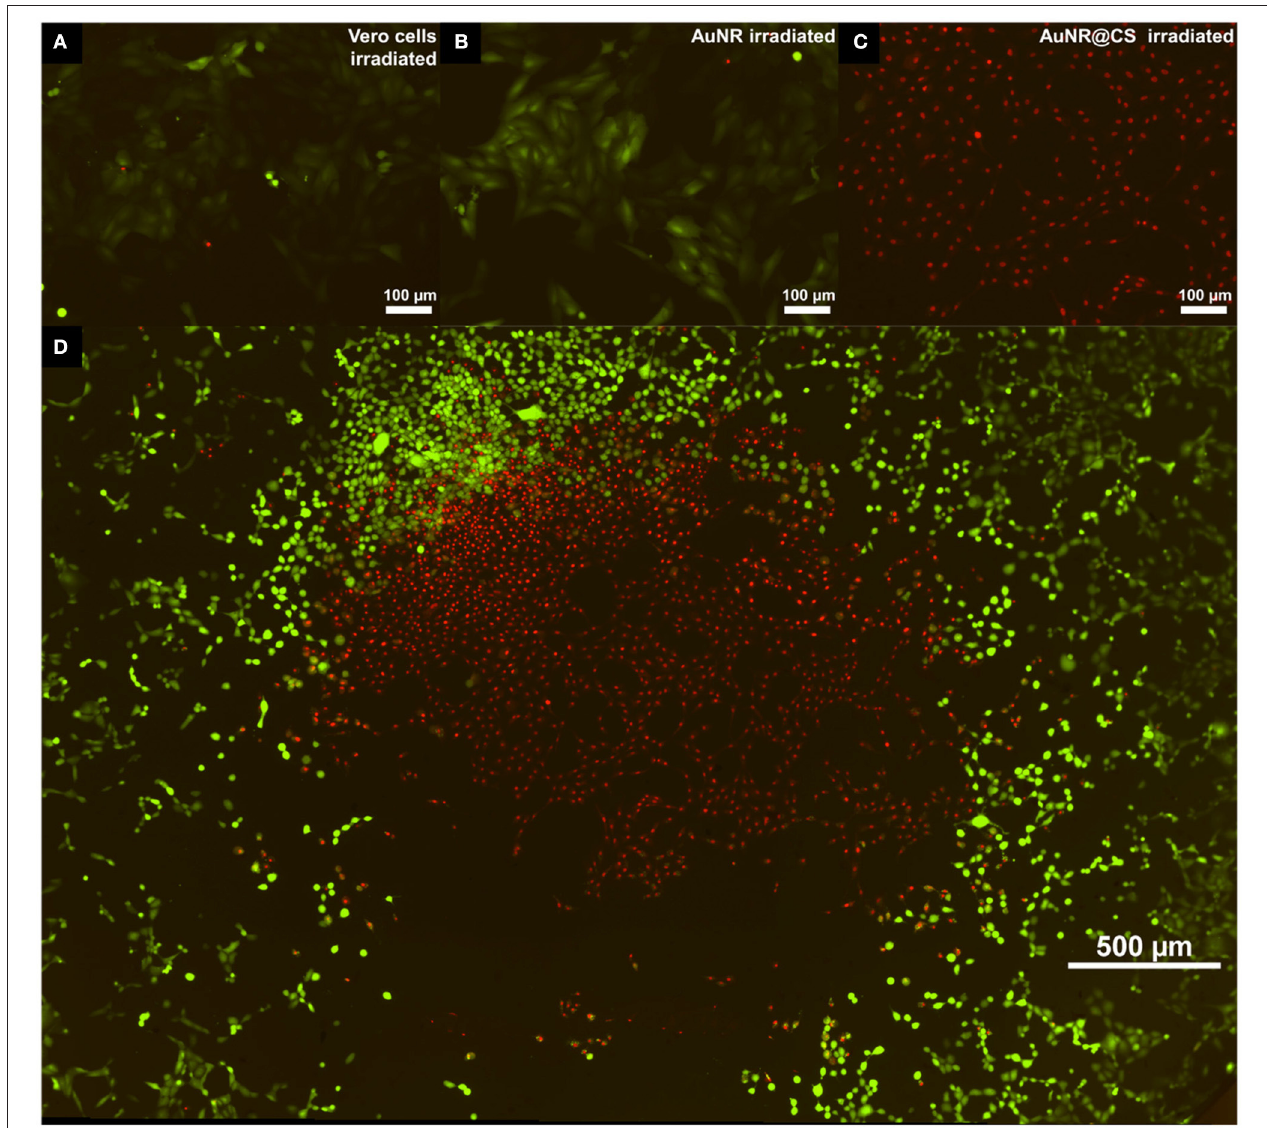
FIGURE 5 | Fluorescent microscopy images of live/dead test 5h post irradiation of untreated cells (A) ; treated with 60 µ g/mL of AuNR (B) ; or with 60 µ g/mL of AuNR@CS (C) . Image (D) shows an entire 96-well irradiation of 60 µ g/mL AuNR@CS with the laser adjusted to irradiate only the central part of the